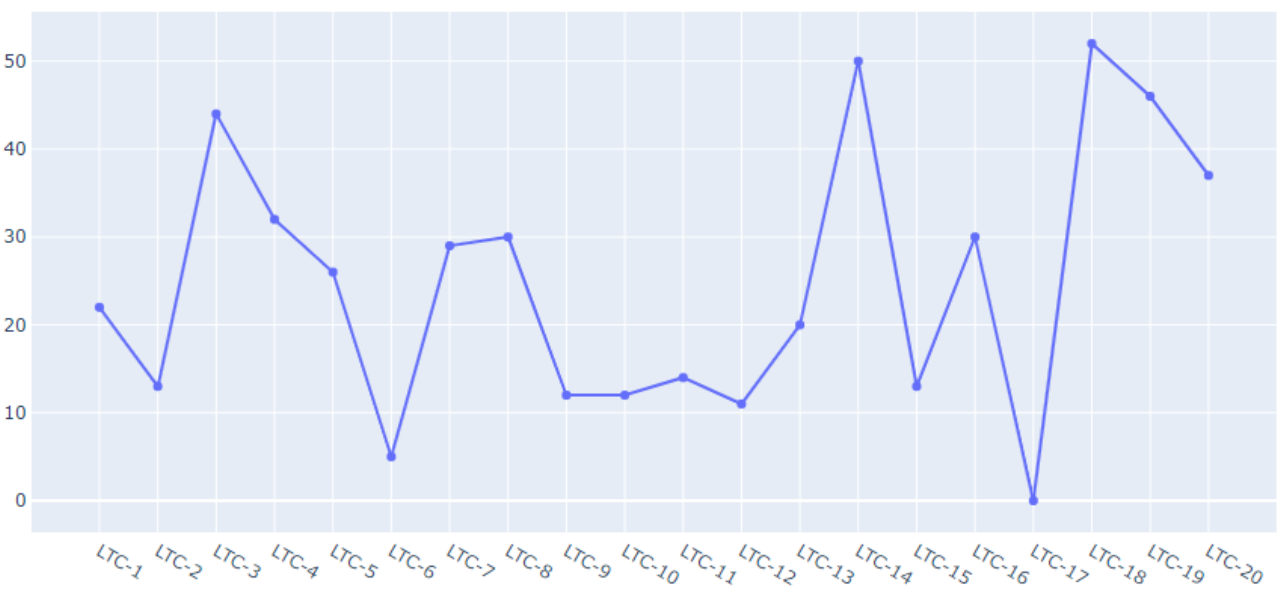
Figure 3. The number of residents participating in recreational and socializing activities before the COVID-19 pandemic.